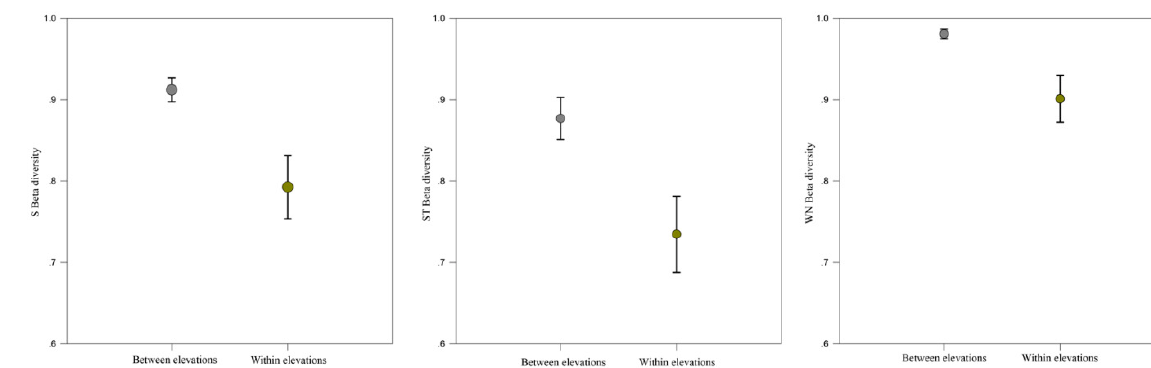
Figure 5. Network turnover comparison between elevation and within elevation (among habitats). From left to right. S Beta diversity ( β S ), ST Beta diversity ( β ST ) and WN Beta diversity ( β WN ) were always higher between elevation than within elevation (all p < 0.05).